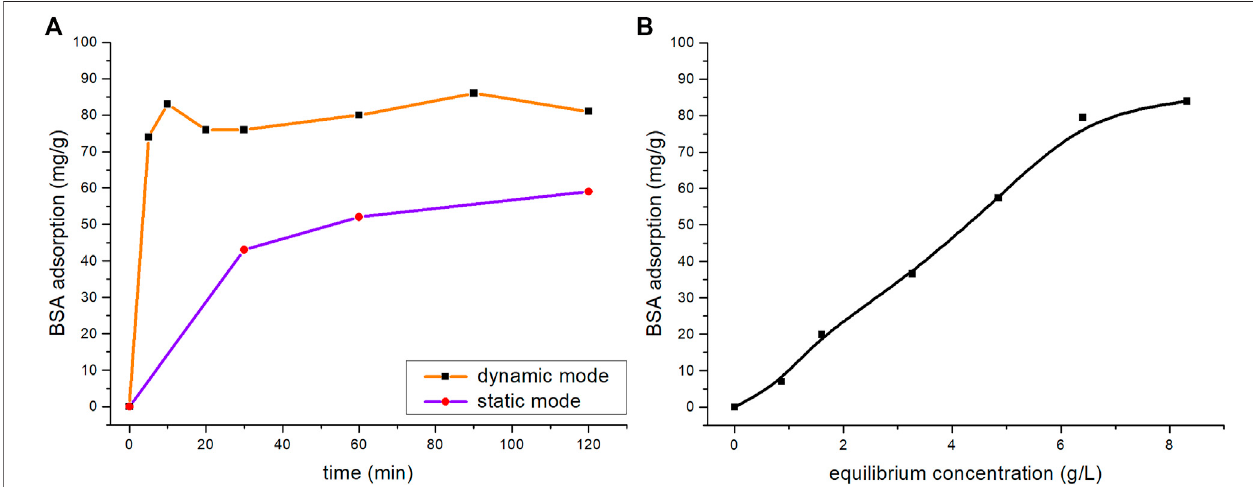
FIGURE 3 | Sorption kinetics of the BSA adsorption on CuS NPs for: (A) dynamic and static modes and (B) sorption equilibrium isotherm.